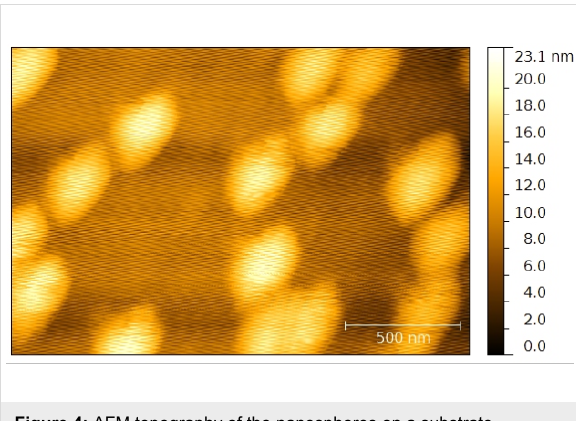
The synthesized nanospheres have a diameter of 20 nm. The nanoprisms were equilateral and their edge size varied from 10 to 100 nm depending on the quantity of seed taken in the second step of the synthesis [18,37]. Their thickness was constant and found to be 10 nm. The NPs were stabilized by citrates and PVP. The colloidal solutions were washed by successive centrifugation steps and redispersed in